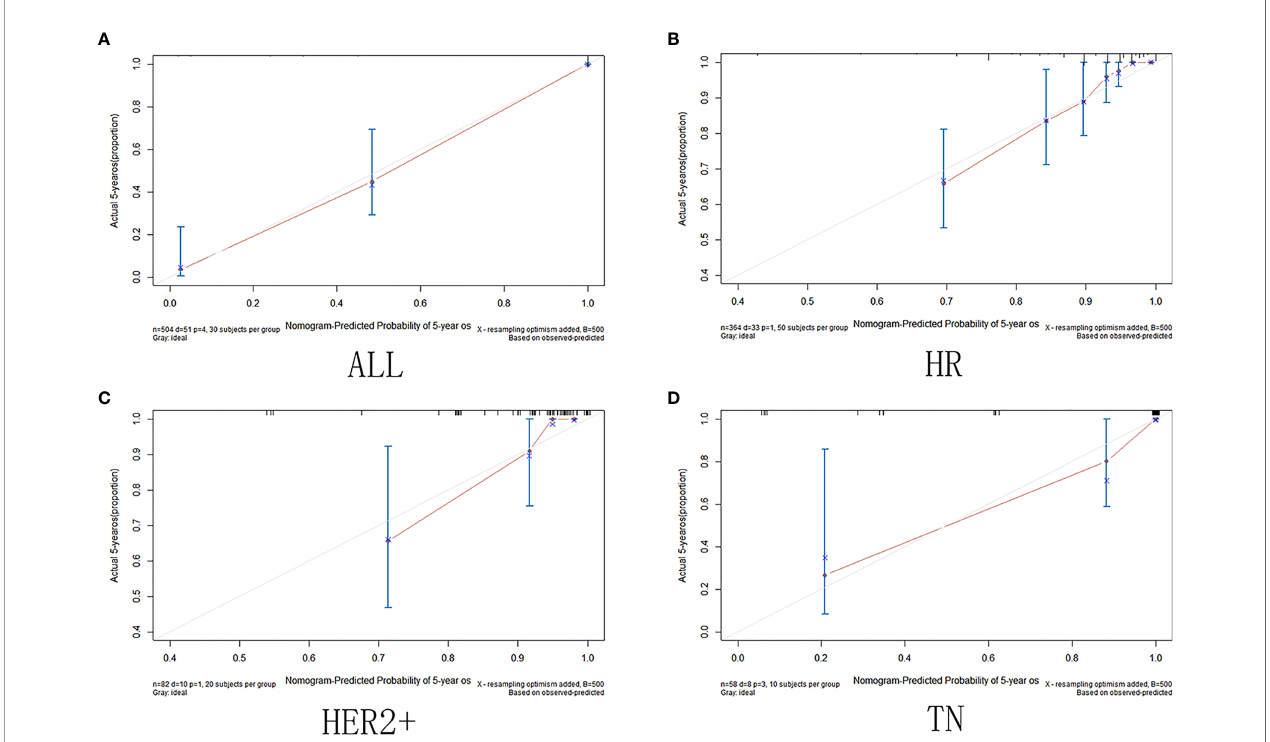
FIGURE 7 | Validation set calibration curve. ( A )among all cases in the validation set; (B) in HR group; (C) in HER2+ group; (D) in TN group.